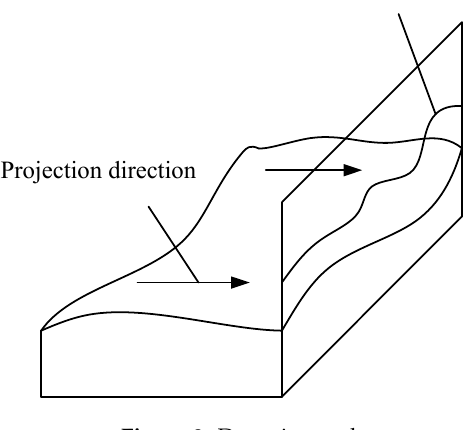
Figure 3. Detection path.